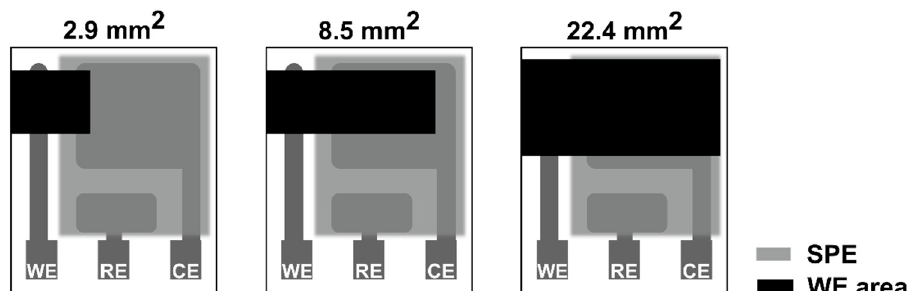
Figure 1. Sensor topology with three different working electrode areas.